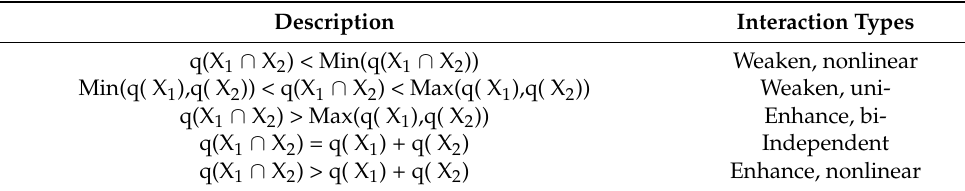
Table 1. Interaction relationships for two factors.